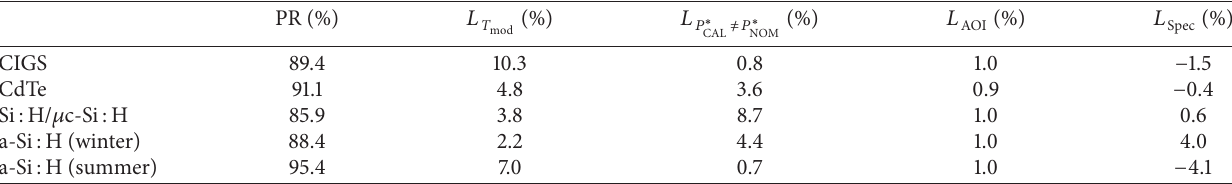
Table 3: Values of performance ratio and different performance losses experienced by the four tested PV modules over the experimental campaign.